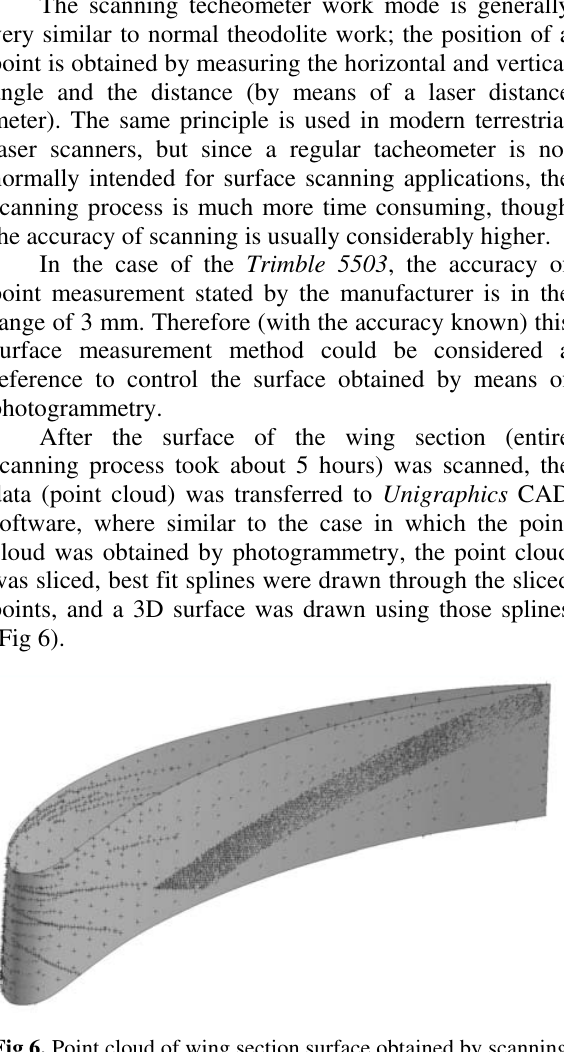
Fig 7. 3D comparison of the surfaces: 1 – created from point cloud obtained by tacheometer measurements; 2 – by photogrammetric measurements